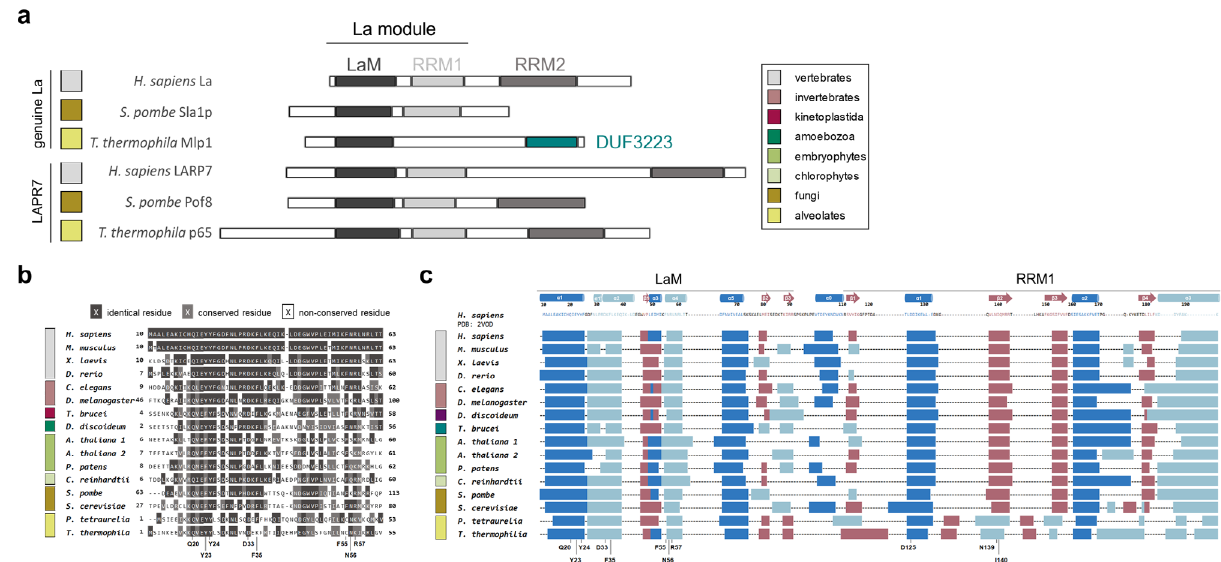
Fig. 1 | Alveolate La proteins are predicted to have a LaM but not an RRM1. a Schematic representation of RNA-binding domains found in La and La-related protein-7(LARP7)fromdifferenteukaryotes.TheLaMandRRM1togetherformthe La module responsible for uridylate binding through formation of a hydrophobic binding pocket between the two domains. LaM La motif, RRM RNA-recognition motif, DUF domain of the unknown function. b Primary amino acid sequence alignments from different eukaryotic lineages showing conservation of uridylate bindingresidues(highlighted,bottom).Adarkgraybackgroundindicatesidentical residues,lightgrayconservedresidues,andwhiteindicatesnoconservation.Color-